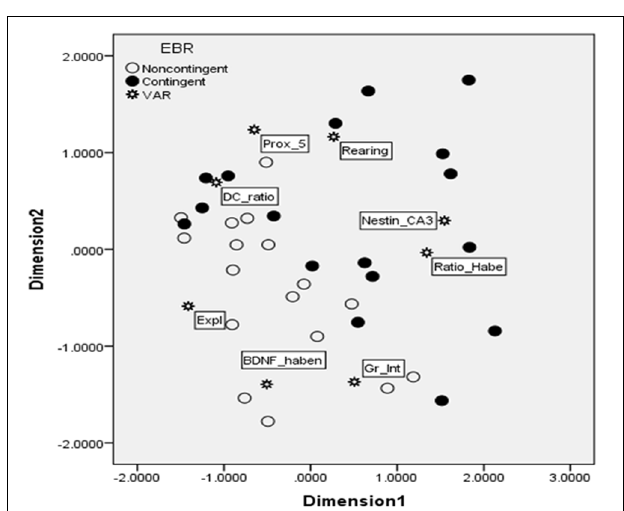
Nestin-immunoreactive tissue (B) ; specifically, lower levels were observed in the flexible contingent trained animals than in the flexible noncontingent animals, an effect not observed in the active and passive coping groups.